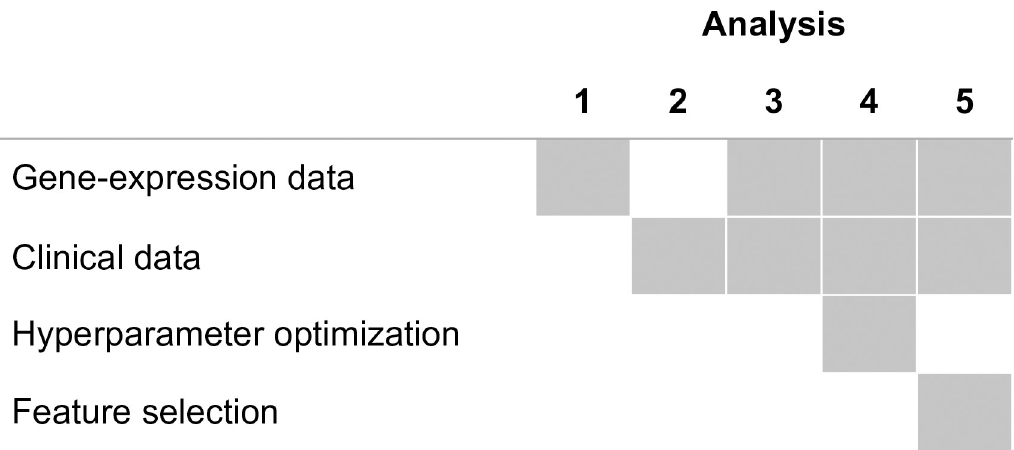
Fig 1. Overview of analysis scenarios. This study consisted of five separate but related analyses. This diagram indicates which data type(s) was/were used and whether we attempted to improve predictive performance via hyperparameter optimization or feature selection in each